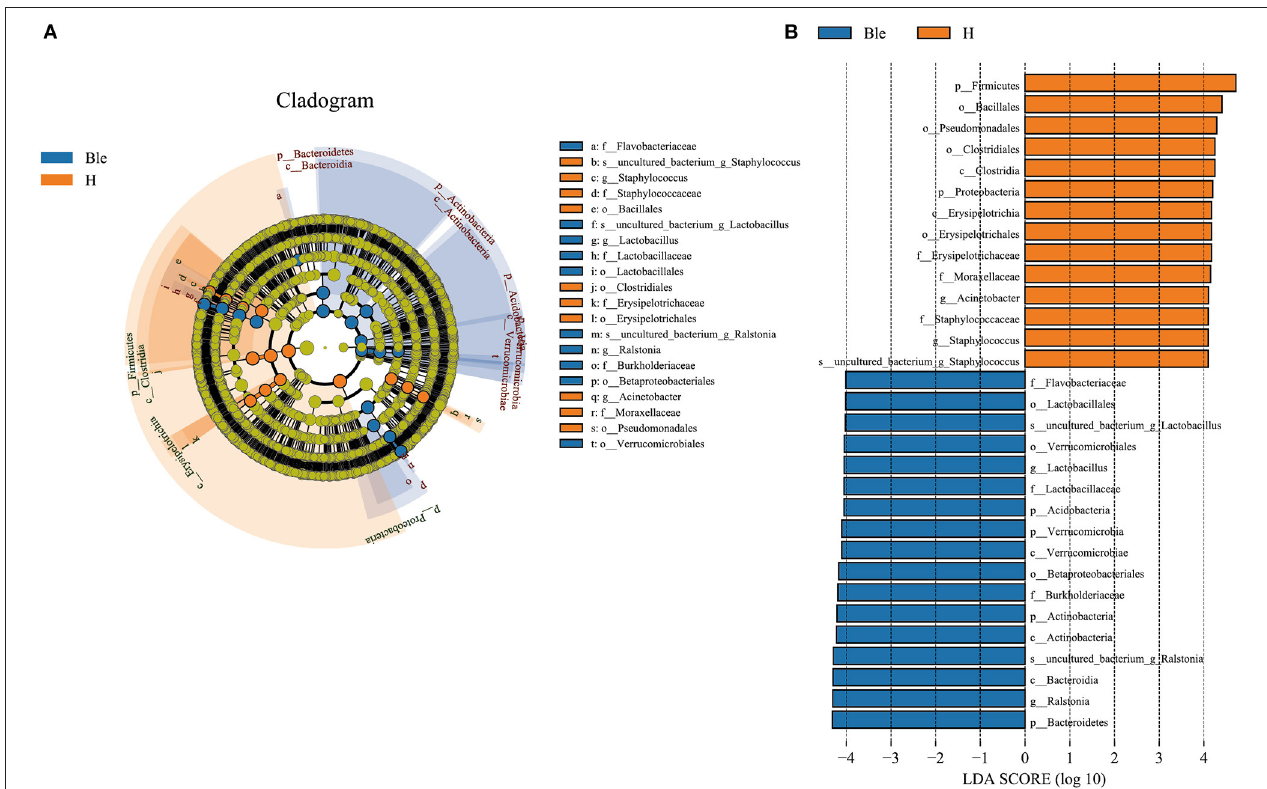
FIGURE 4 | LEfSe analysis of the blepharitis group and healthy control group. (A) A cladogram of the ocular surface microbial taxa in the blepharitis (Ble) and healthy control groups (H) showing the levels from phylum to species from outside to inside. (B) Linear discriminant analysis (LDA) scoring of biomarkers corresponding to (A), computed by the LEfSe tool. When the score of a taxon was > 4.0 with P < 0.01, it was listed in the histogram.